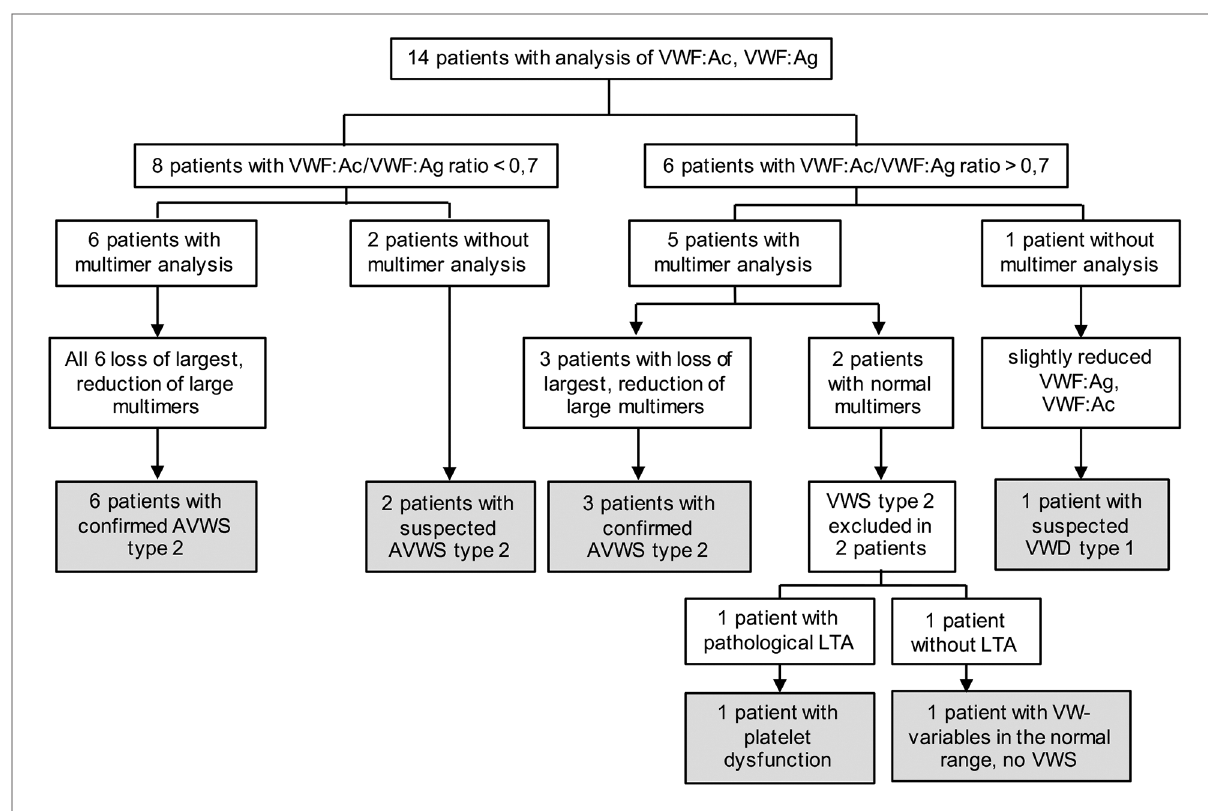
FIGURE 2 Results of diagnostic